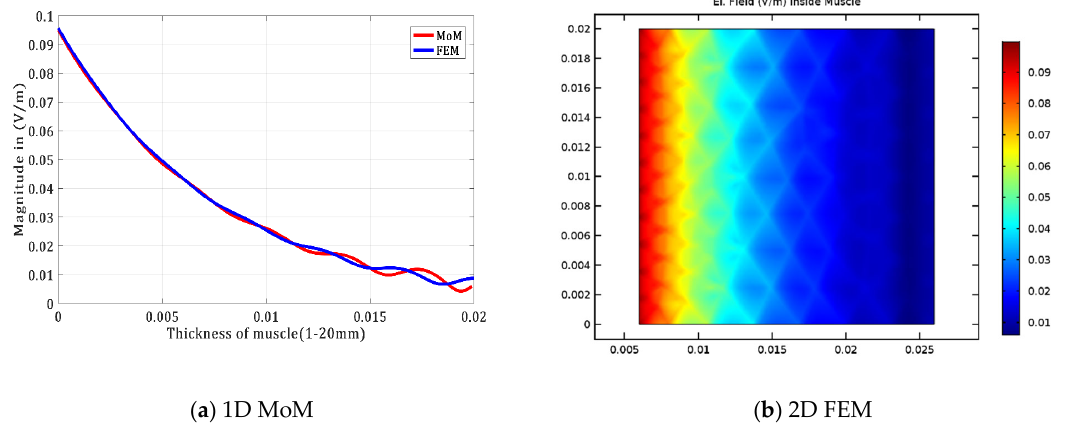
Figure 6. E ‐ field inside muscle tissue for both methods at 5.8 GHz.